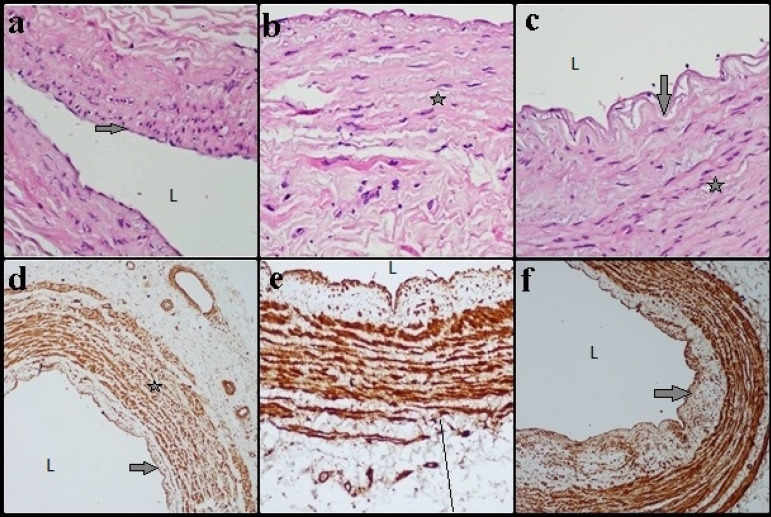
Group I (coronary artery disease): vein sections stained with hematoxylin-eosin (a, b, and c) and parts stained for immunoreactivity with urotensin-II (d, e, and f). Endothelial cells, media layer vascular smooth muscle cells, and internal elastic lamina (IEL) were evaluated as ‘in normal structure’. Down arrow=IEL; right arrow=endothelial cells; star=tunica media. L=lumen. Scale bar=50 µm.